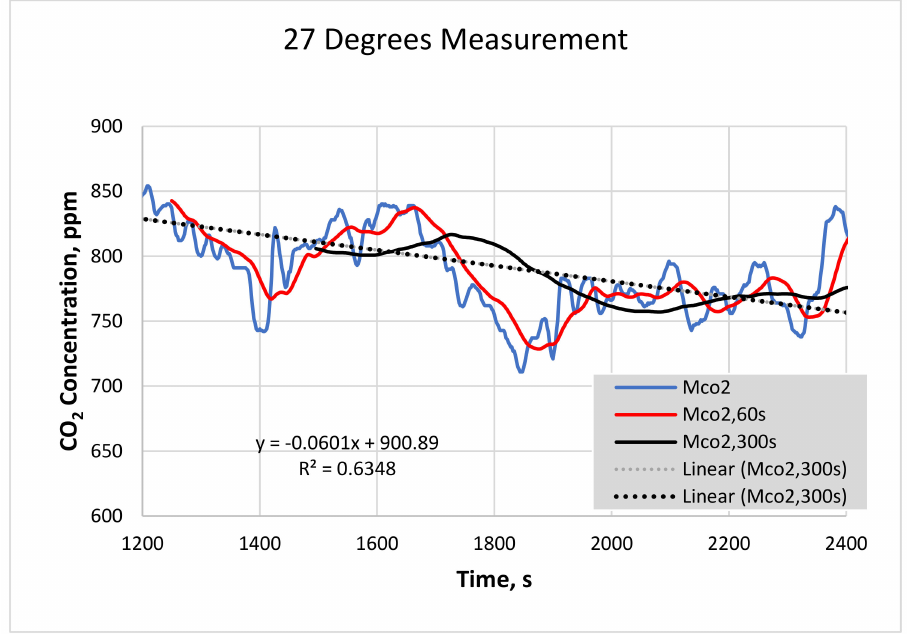
Figure 18. CO 2 concentration, exposure at 27 ◦ C: instantaneous data Mco 2 (blue curve); evolution curve of the CO 2 concentration, time-averaged for 60 s, Mco 2,60s (red curve); and evolution curve of the CO 2 concentration, time-averaged for 300 s, Mco 2,300s (black curve).